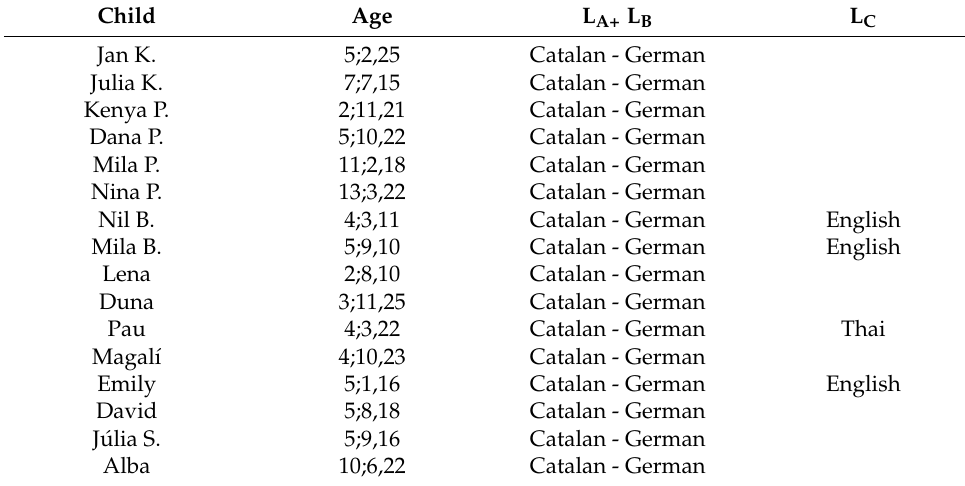
Table 2. Children according to age and L1s. Child